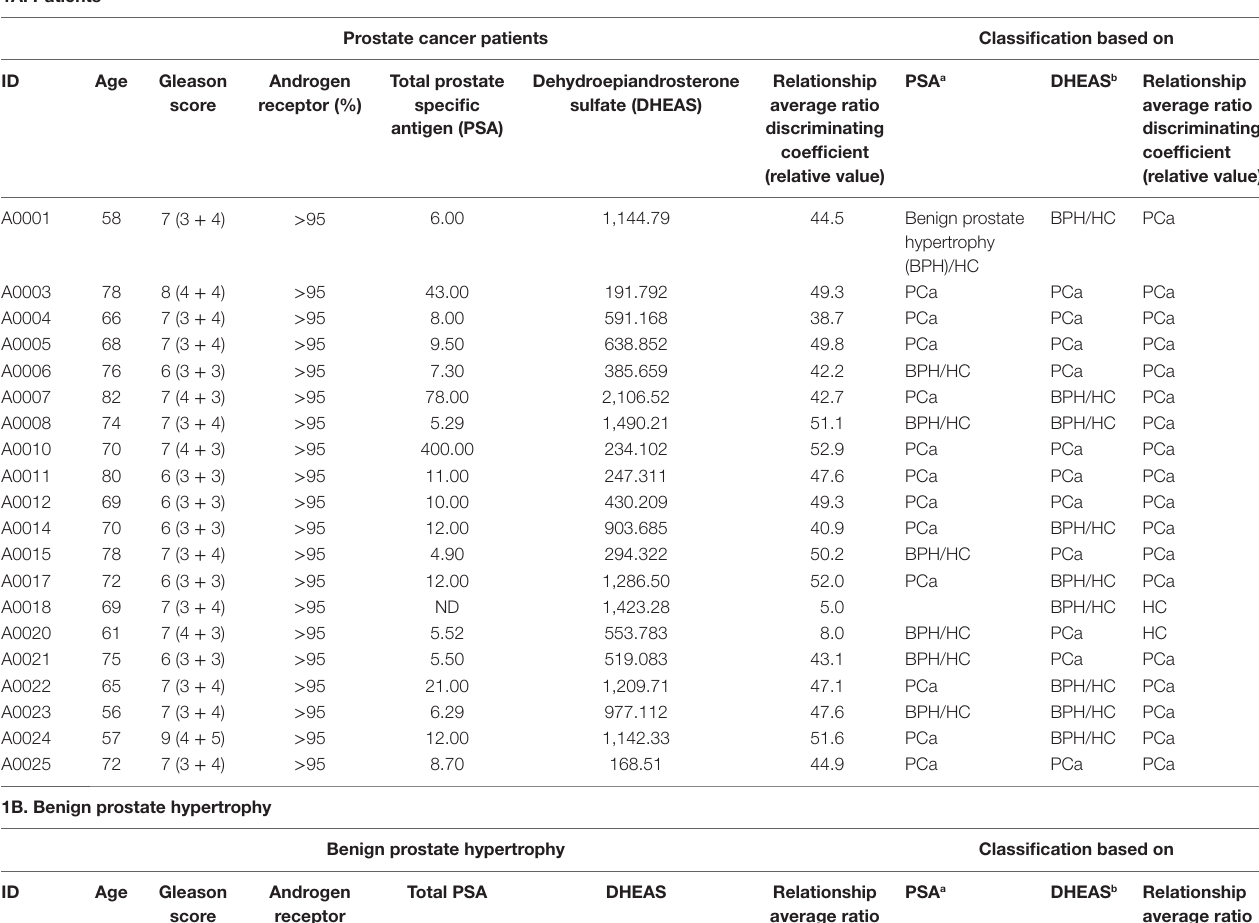
TaBle 1 | Clinical characteristics of the (a) patients, (b) Benign prostate hypertrophy, and (c) controls subjects. 1a.